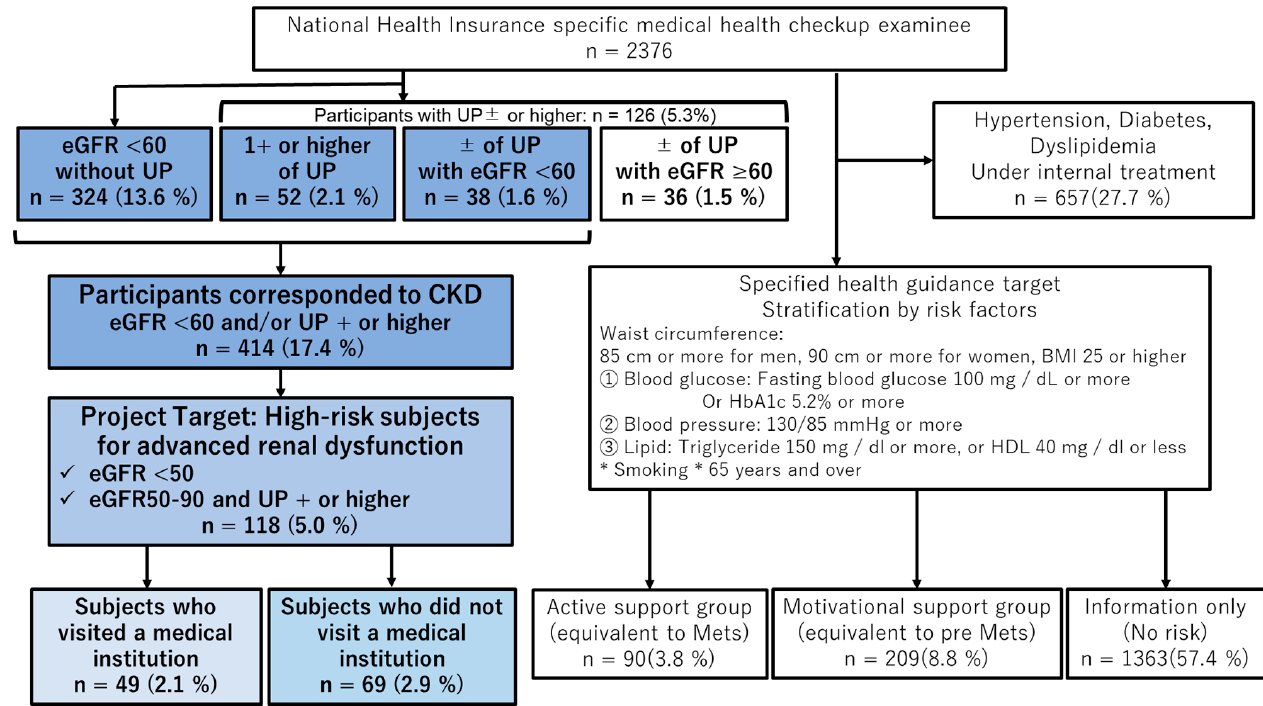
Figure 1. Diagram of participants enrolled in this study.